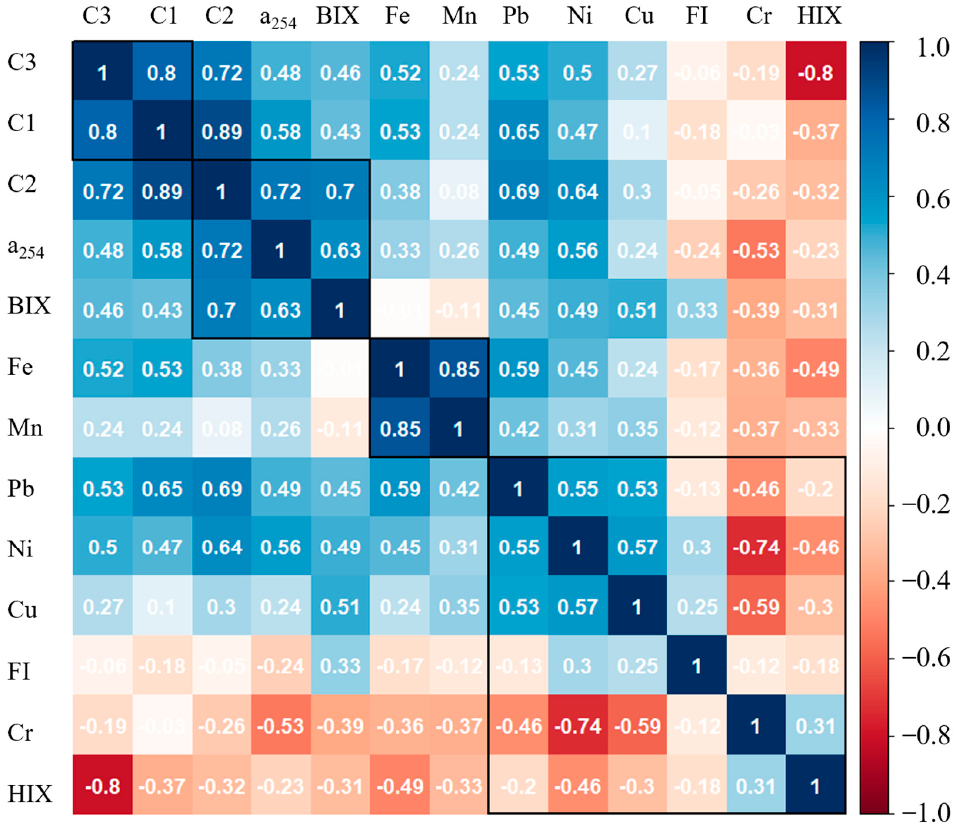
Figure 8. Spearman’s correlation analysis results between heavy metals and (C)DOM optical characteristics of sediments. Blue color means positive correlations and the red refers to negative correlations.